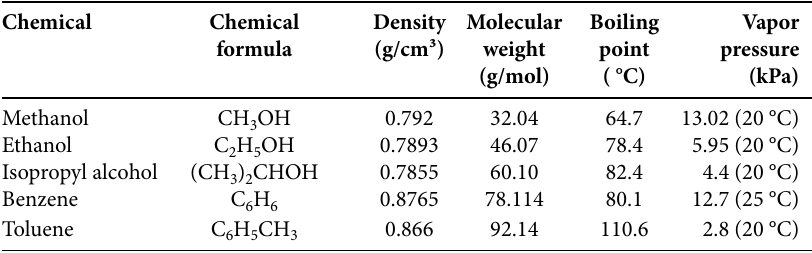
Table 2. Physicochemical properties of adsorbates